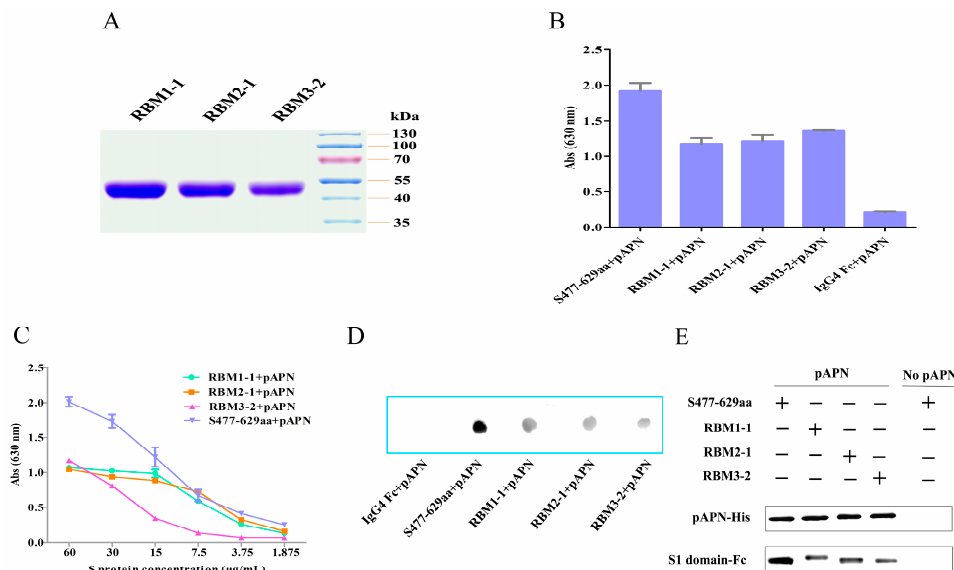
Figure 5. The effect of mutation of the three loops on pAPN binding. ( A ) Purified RBM1-1, RBM2-1, and RBM3-2 proteins with a C-terminal IgG 4 Fc tag were detected by SDS-PAGE; ( B ) An ELISA was performed to detect the binding between the CHGD-01 S 477–629 , RBM1-1, RBM2-1, RBM3-2 (60 μ g/mL), and pAPN. The IgG 4 Fc protein was used as a control. ELISA plates were coated with the